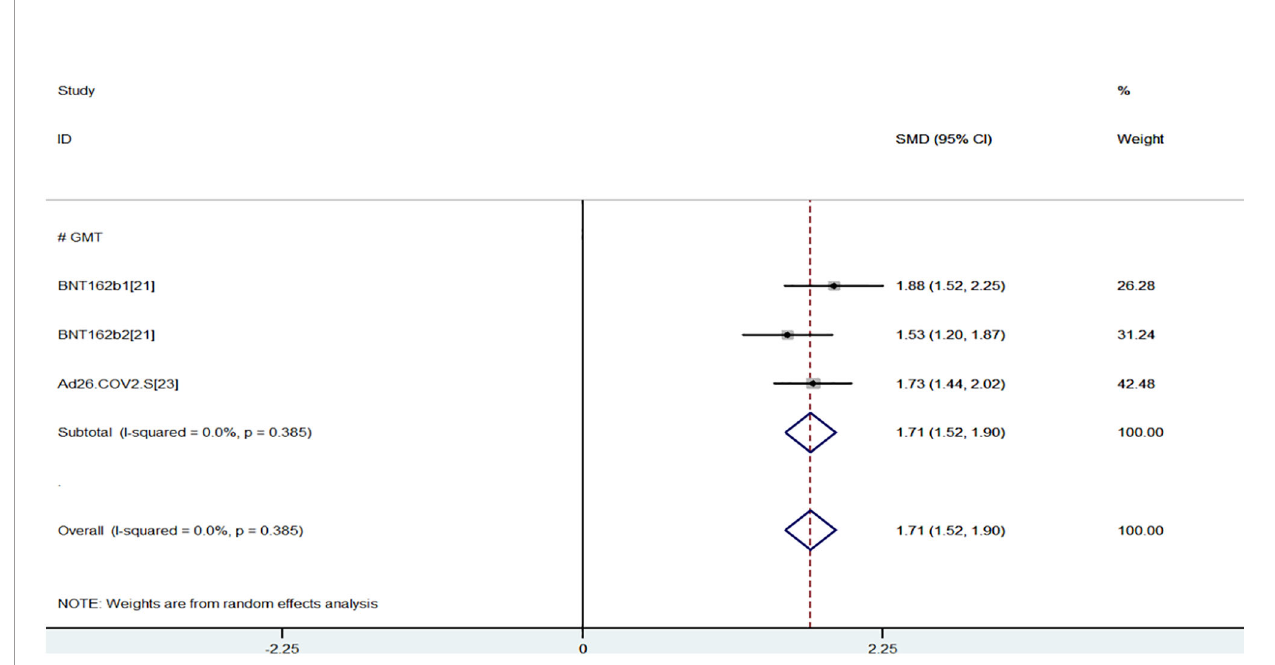
FIGURE 3 | Meta-analysis of GMT between the experimental group (young adults) vs control group (older